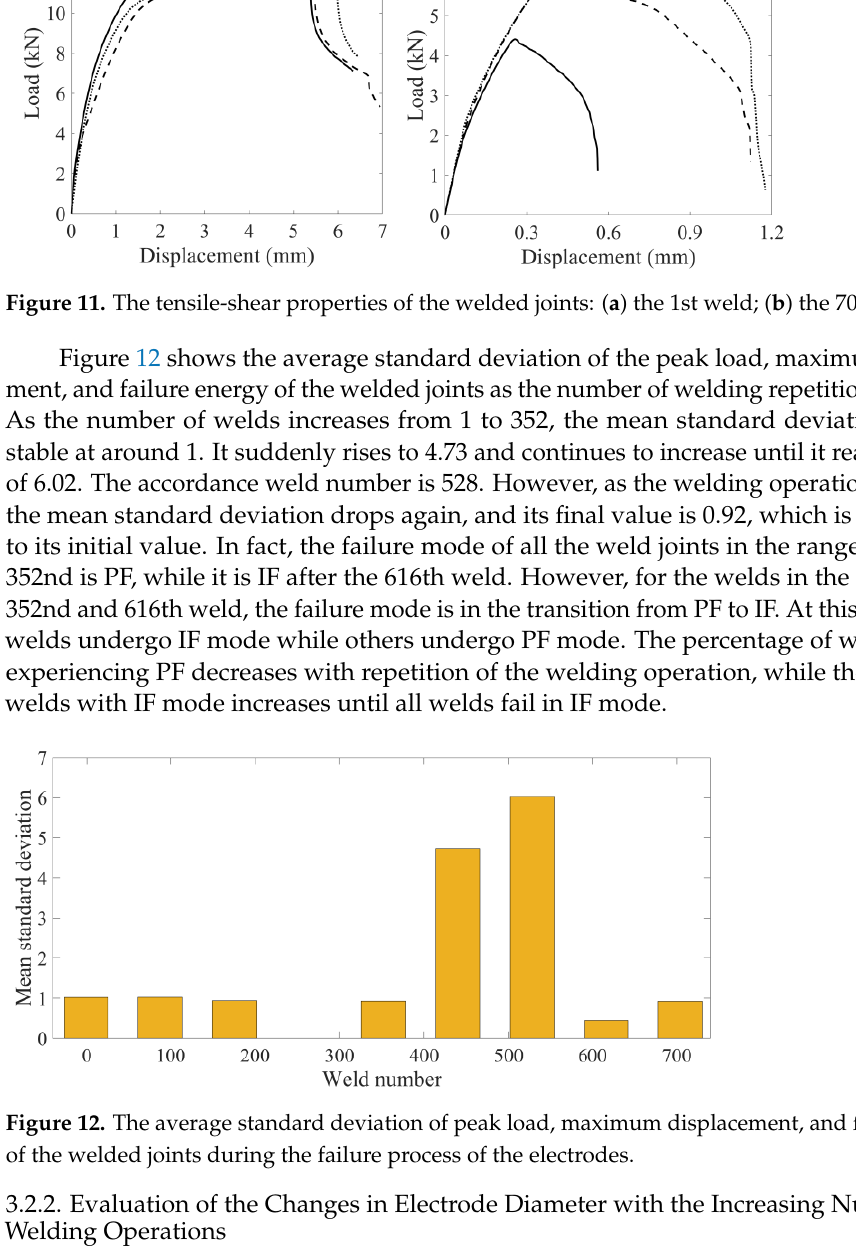
Figure 10. The mechanical attributes of the welded joints during the failure process of the electrodes.